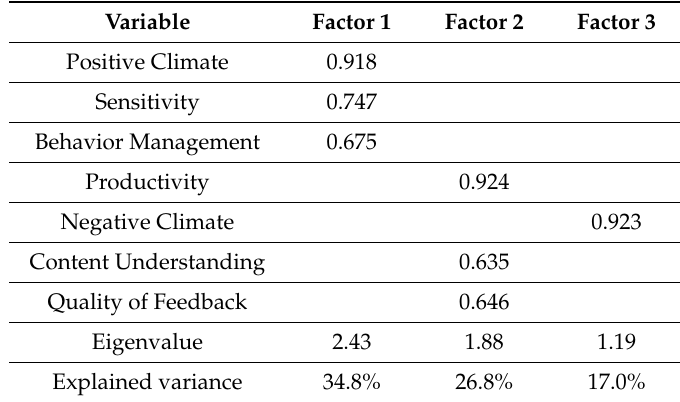
Table 5. Results of factor analysis after Varimax rotation (three-factor solution): values represent factor loadings for the